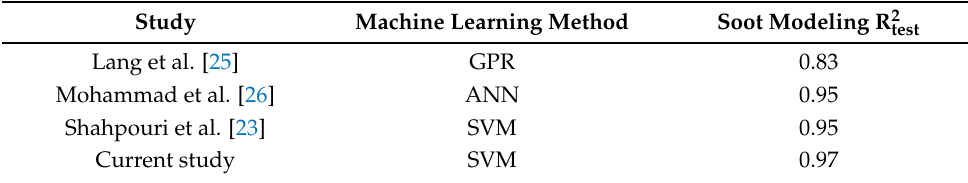
Table 6. Comparison between studies about soot emissions modelling using gray-box models.